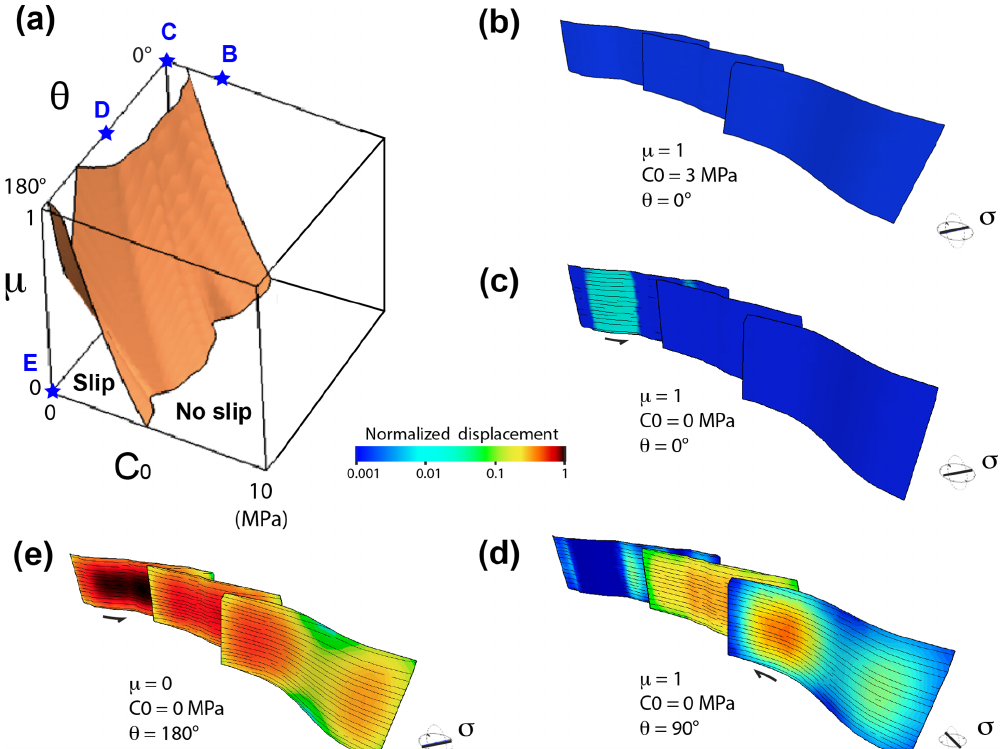
Figure 4. Examples of 3-D quasi-static fault displacement distributions on the Landers model for different mechanical conditions and uniaxial stress orientation. (a) Fault slip envelope shown in Fig. 3d with reported specific model conditions used for panels (b) , (c) , (d) , and (e) (blue stars). (b) Displacement distribution for µ = 1, C 0 = 0MPa, and θ = 0 ◦ . (c) Displacement distribution for µ = 1, C 0 = 3MPa, and θ = 0 ◦ . (d) Displacement distribution for µ = 1, C 0 = 0MPa, and θ = 90 ◦ . (e) Displacement distribution for µ = 0, C 0 = 0MPa, and θ = 180 ◦ . The color bar scale for displacement is